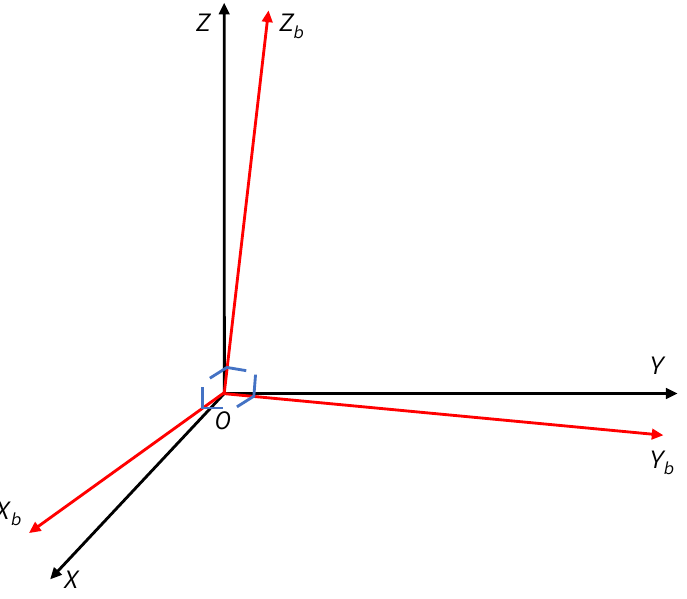
Figure 8. Misalignment